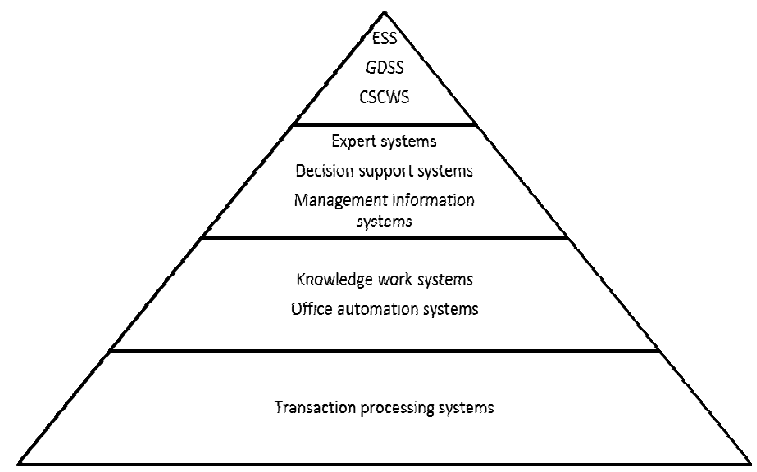
Figure 1: Different system levels (Kendall & Kendall, 2011:30) With figure 1 in mind, the following arguments help one to understand that most SMEs are really applying information technology on the lower levels and in the majority of cases not higher than the MIS level of the